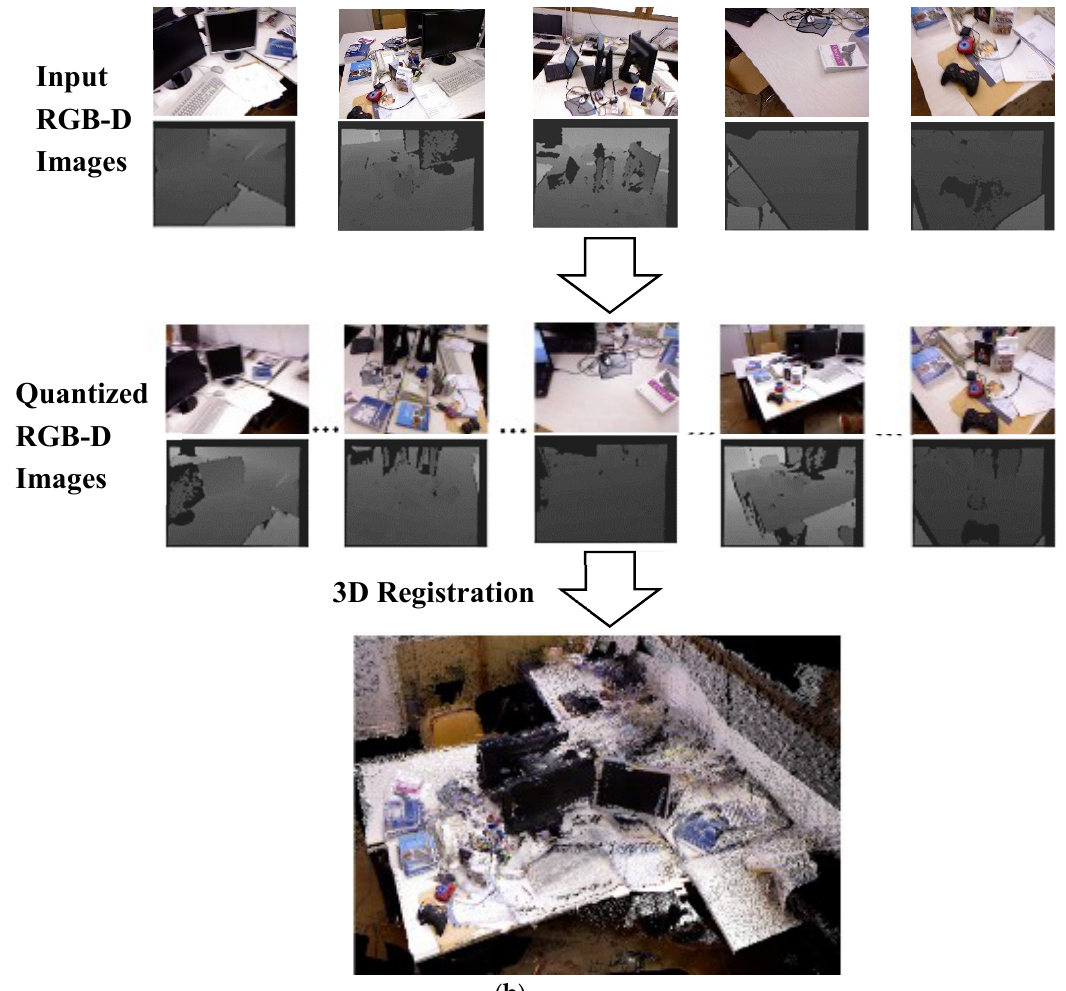
Figure 11. ( a ) An example of the 2D trajectory and error of the proposed method using the test dataset ‘freiburg1_desk’. ( a1 , a2 ) are the 2D trajectory error without and with the removement of the outliers of corresponding pairs, respectively, when using Algorithm 3 to estimate the poses. ( a3 ) is the difference comparison of the bounding box in ( a1 , a2 ). ( b ) The reconstructed 3D scene using the proposed template-to-frame registration technique. Table 2. Camera pose error for datasets with ground-truth from [44] in terms of RMSE of the relative error. The value of k is the number of training RGB images in a viewpoint class in our approach, and the stride to select the key-frames from the training datasets in other approaches.